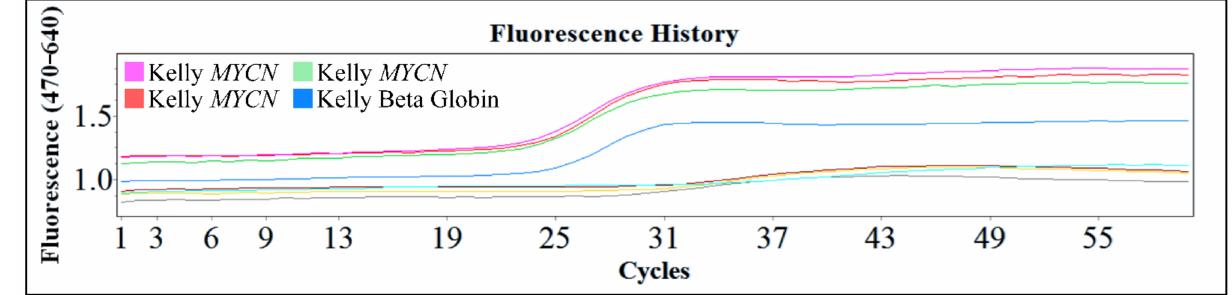
Figure 15. An example of real-time PCR with the Kelly cell line from in-house unpublished